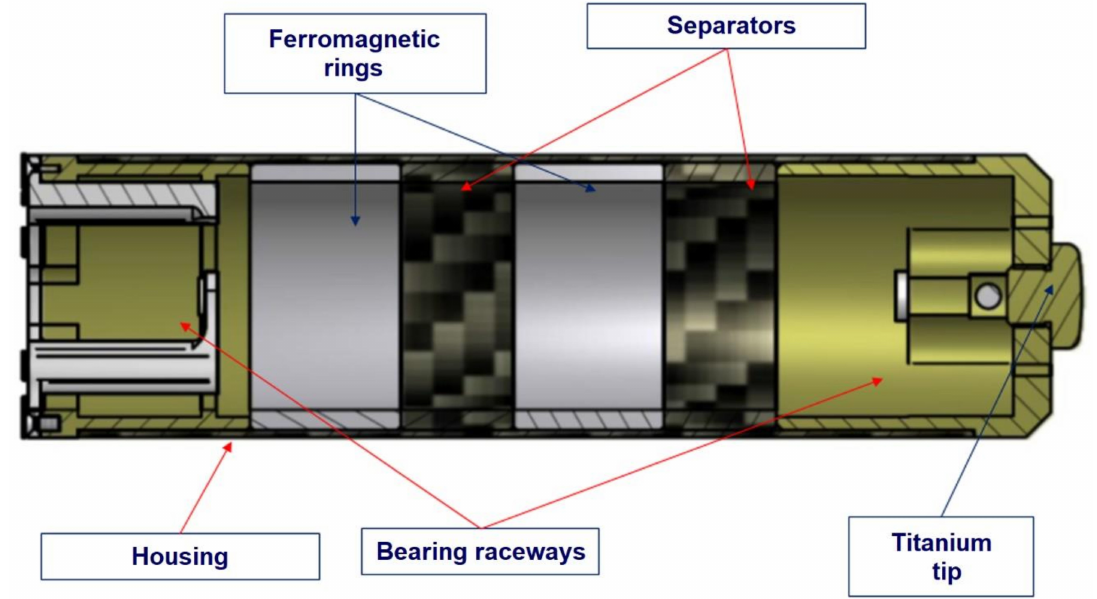
Figure 13. Cross-section showing hammer components.